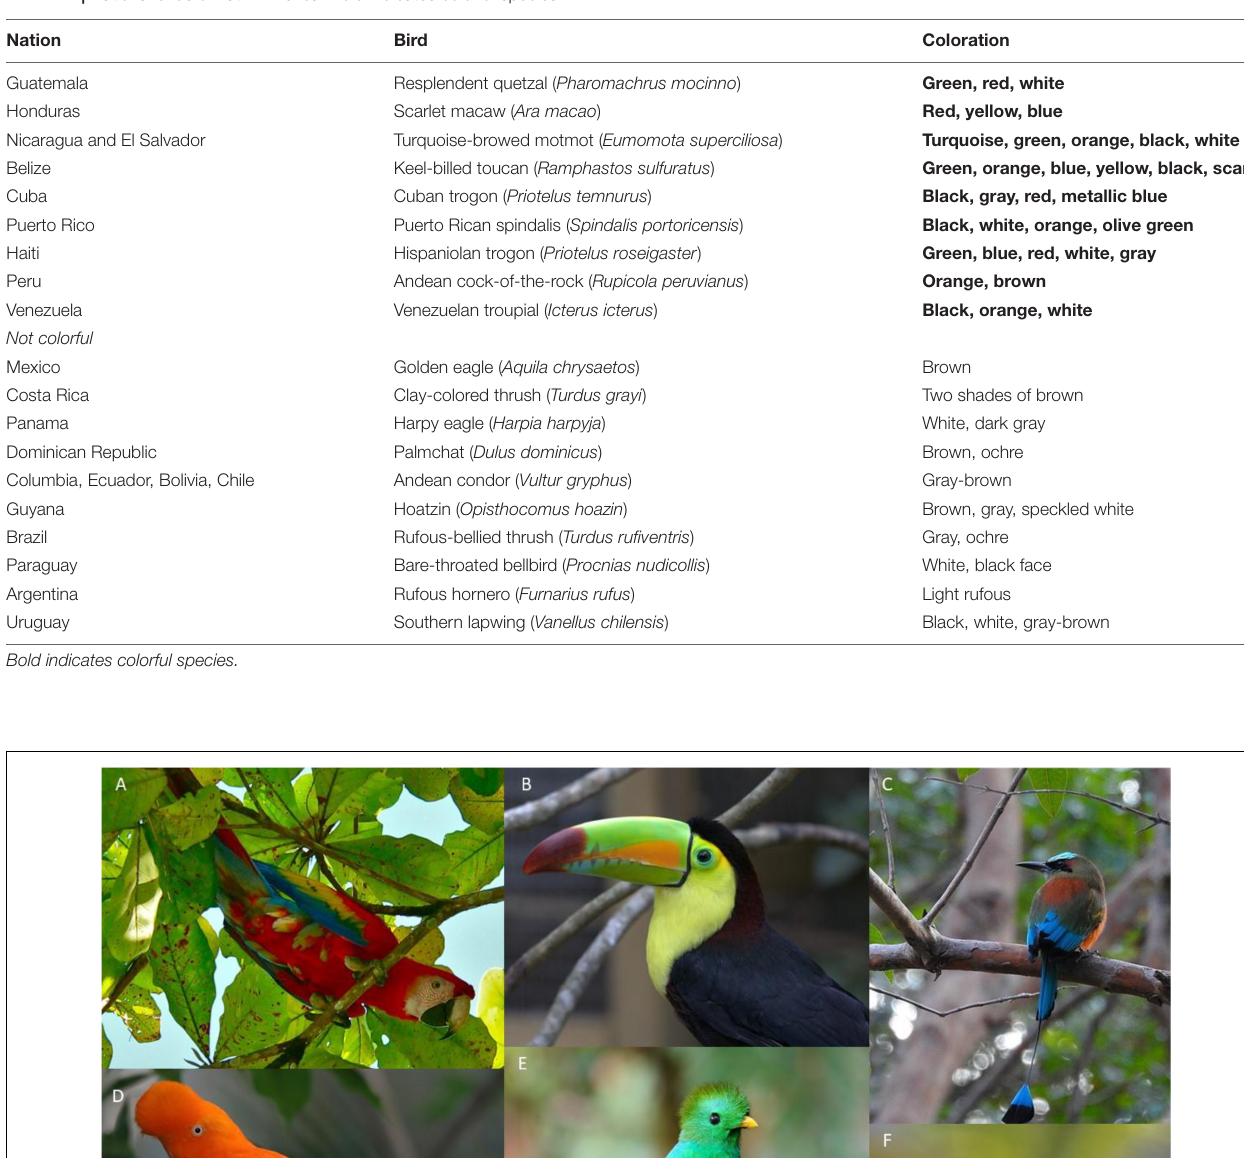
TABLE 2 | National birds of Latin America. Bold indicates colorful species. Nation